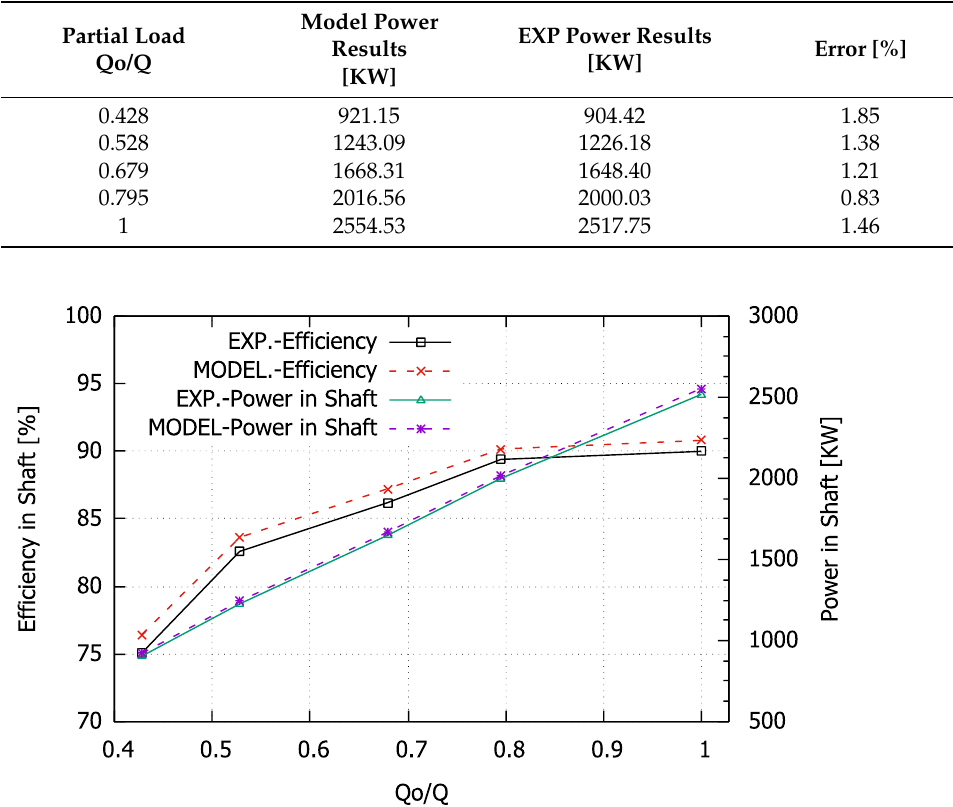
Figure 12. Experimental Validation.